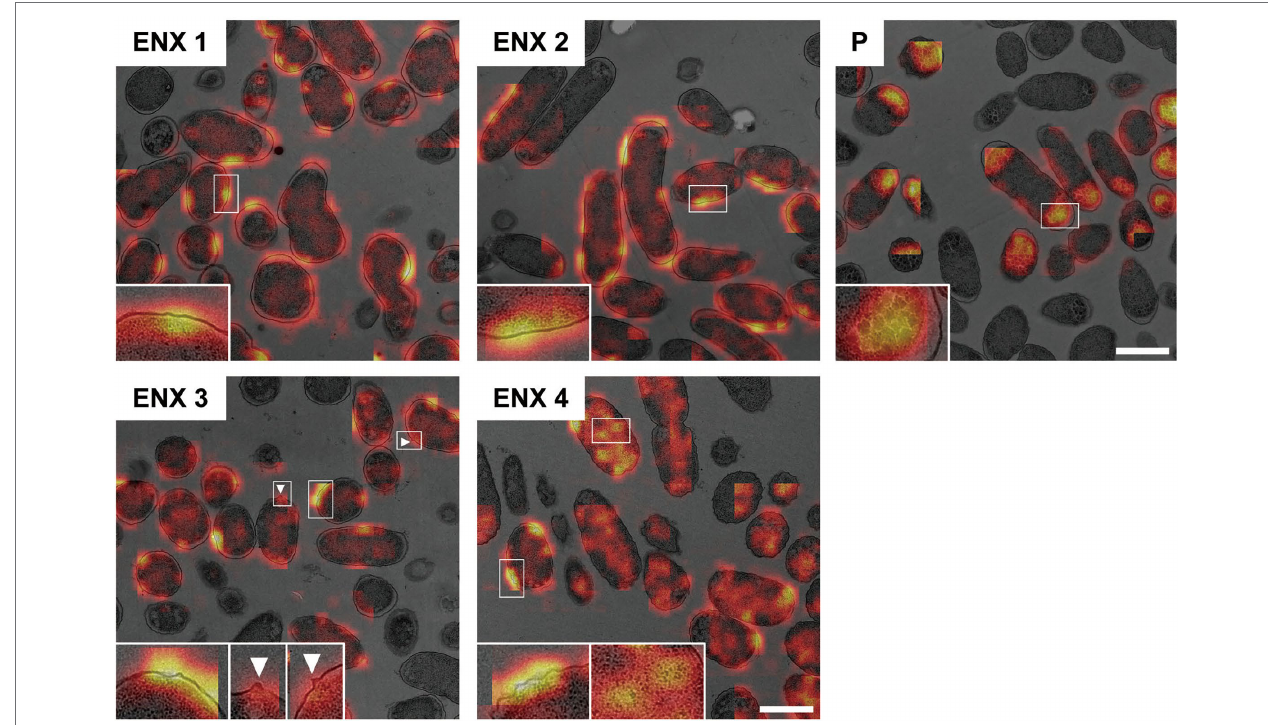
FIGURE 6 | Visualization of the discriminative parts of bacterial cells using Grad-CAM. The representative Grad-CAM images generated from fold three by the accumulation of patchwise results on their corresponding images are shown. Insets depict the magnification of the boxed regions in each image. White arrowheads indicate bleb-like structures. Scale bars, 1 μ m.